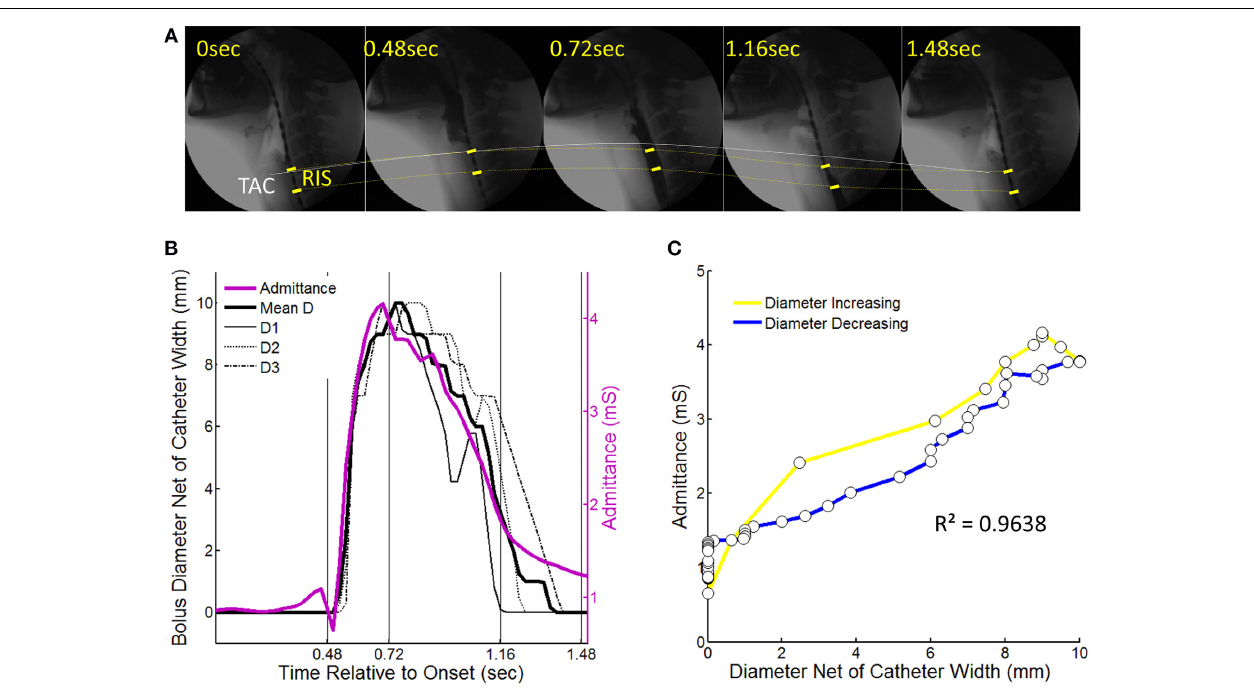
FIGURE 4 | An example of a 10ml liquid swallow showing the temporal correlation of luminal diameter and intraluminal admittance at the level of the reference impedance segment (RIS). (A) Sequential images from swallow onset (laryngeal elevation) showing barium passing through the RIS. Dotted lines chart the trajectory of movement of the tracheal air column (TAC, white line) and the RIS (yellow dotted line). Note decoupling of the TAC and proximal margin of the RIS at time